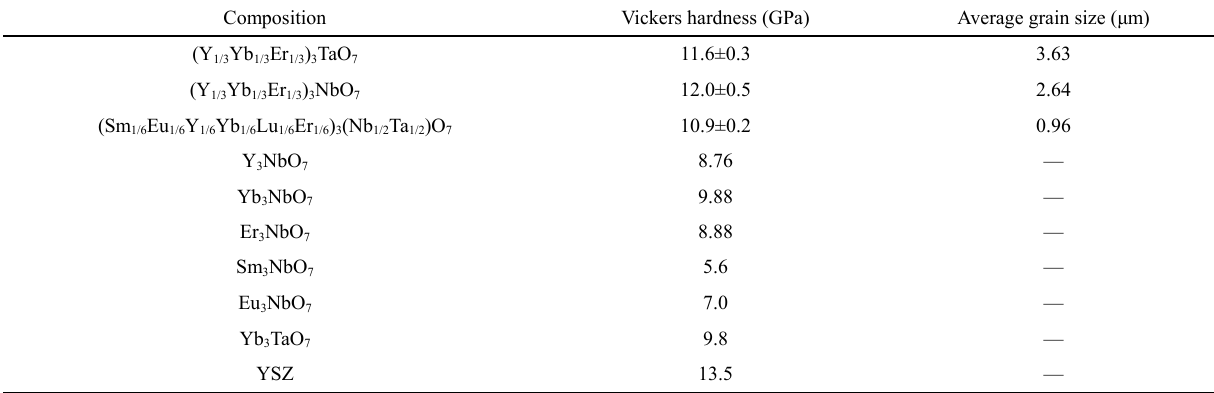
Table 3 Vickers hardness and average grain size of HE RE 3 TaO 7 , RE 3 NbO 7 , and RE 3 (Nb 1/2 Ta 1/2 )O 7 measured at a 9.8 N load. The Vickers hardness of RE 3 NbO 7 , RE 3 TaO 7 , and YSZ are also included for